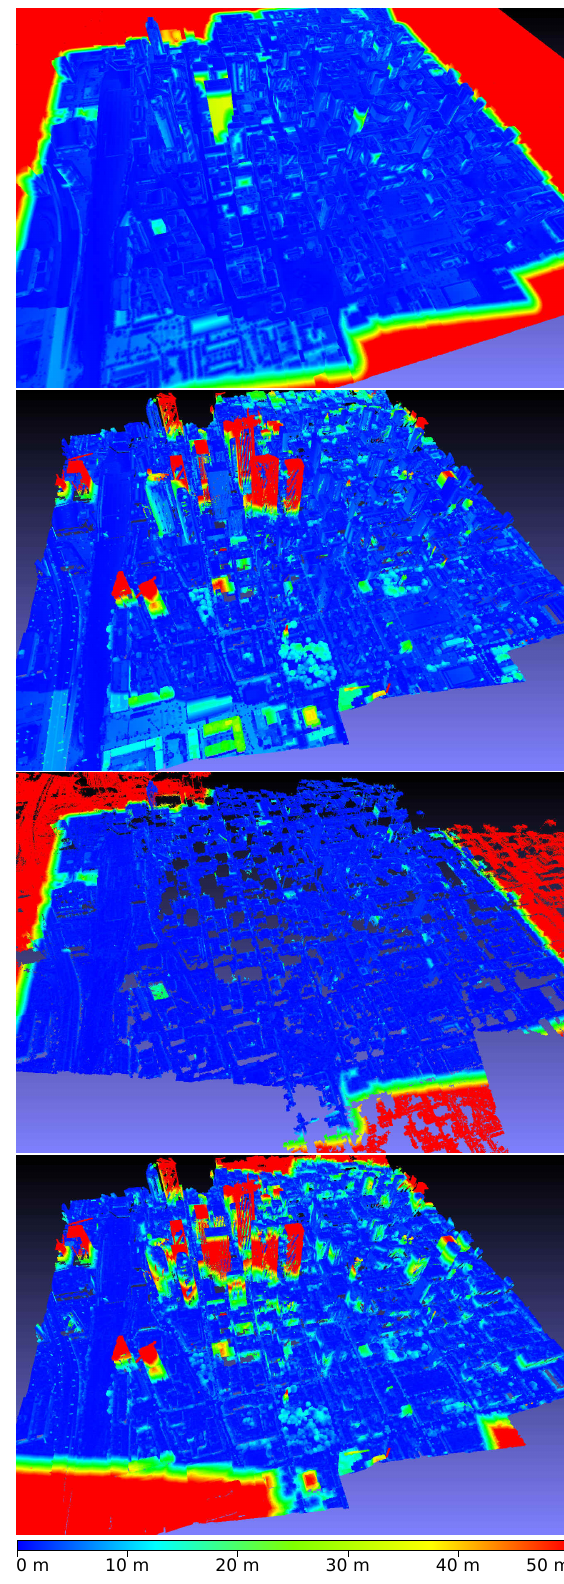
Figure 9. Precision and completeness as color coded point clouds. Blue corresponds to a distance of zero, red to a distance of 50 m . From top to bottom: Precision of the proposed method, completeness of the proposed method, precision of the MVS point cloud, and completeness of the MVS point